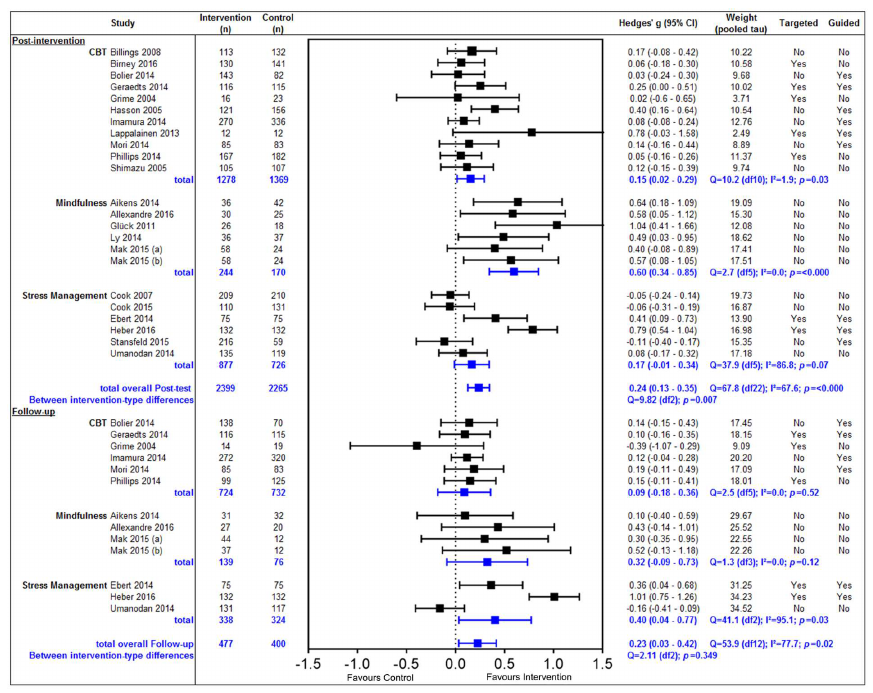
Fig 2. Effect of eHealth interventions in the